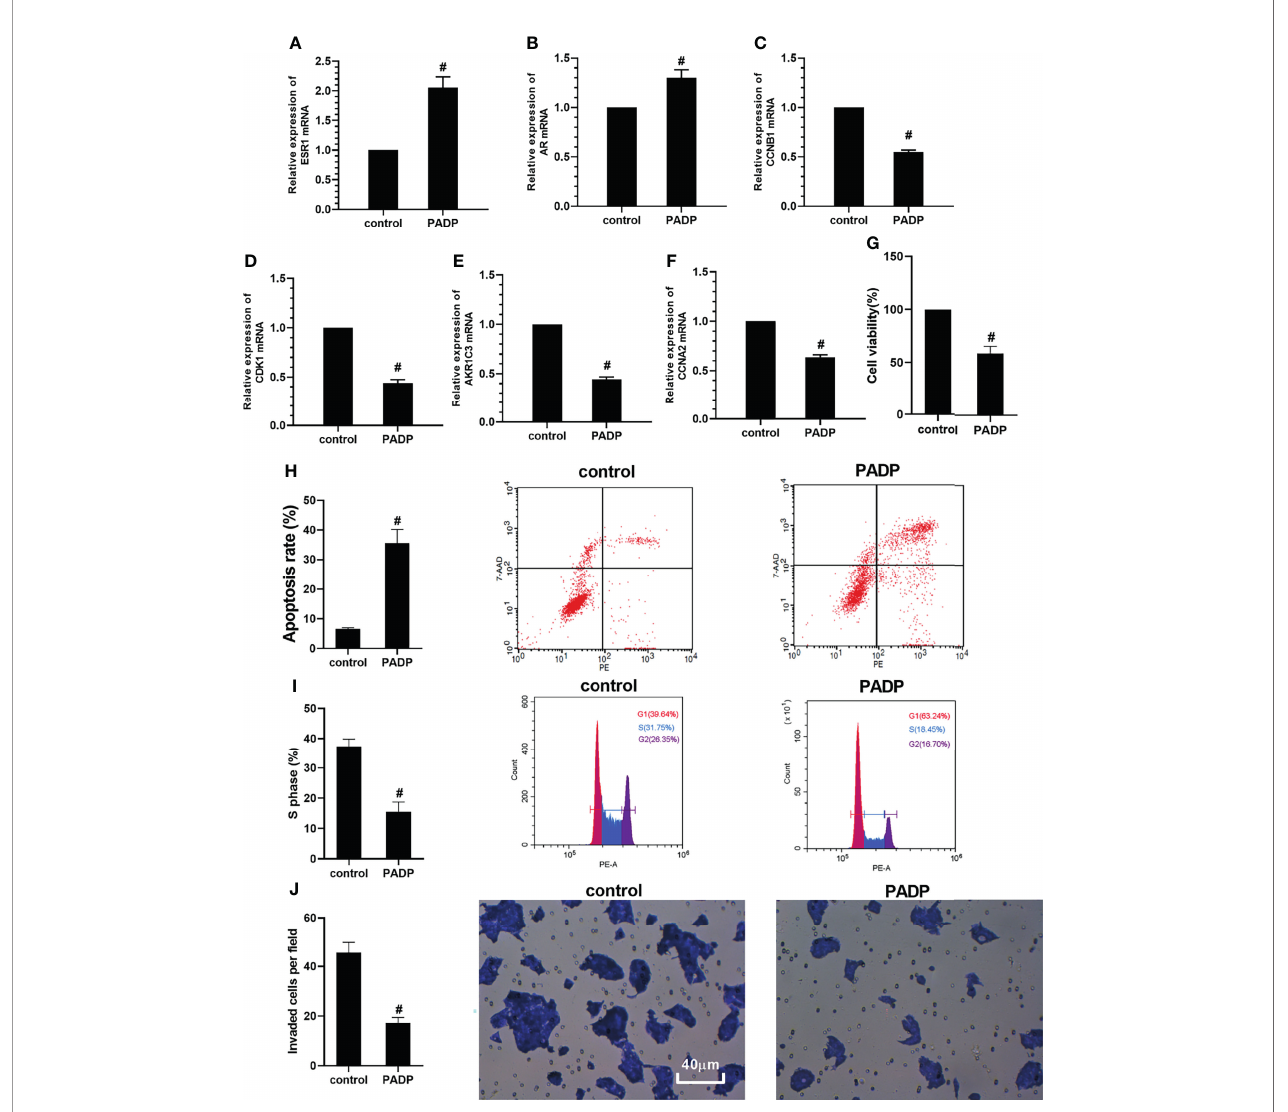
FIGURE 5 | Effect of PADP on the mRNA expression of key target genes and on the cell proliferation, apoptotic and cell cycle and invasion of HepG2 cells. Effect of PADP on the mRNA expression of ESR1 (A) , AR (B) , CCNB1 (C) , CDK1 (D) , AKR1C3 (E) and CCNA2 (F) . CCK − 8 assay was performed to detect cell viability (G) . Flow cytometry was performed to detect the apoptotic rate (H) and proportion of S phase cells (I) . Transwell invasion assay was performed to detect cell invasion (J) . Values are expressed as mean ± SD. # P < 0 05, compared with control